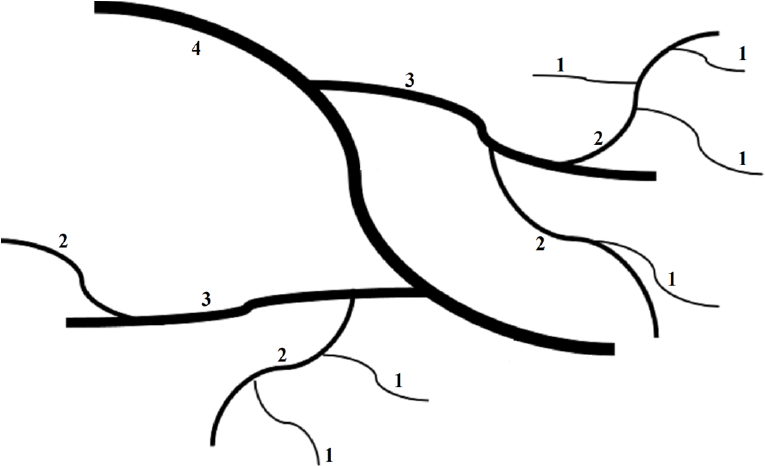
Figure 1. Schematic diagram of a root sequence [16]. 1 is the first-order fine roots; 2 is the second- order fine roots; 3 is the third-order fine roots; and 4 is the fourth-order fine roots. Soil samples were collected according to random and uniform sampling standards.